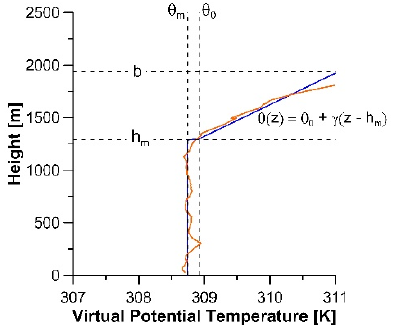
Figure 3. Slab model for the vertical profile of VTP under convective conditions. The thickness of both the entrainment zone and the surface layer is assumed infinitesimal (negligible). The straight dark lines represent the model VPT profile. We used a similar model for the SH profile.